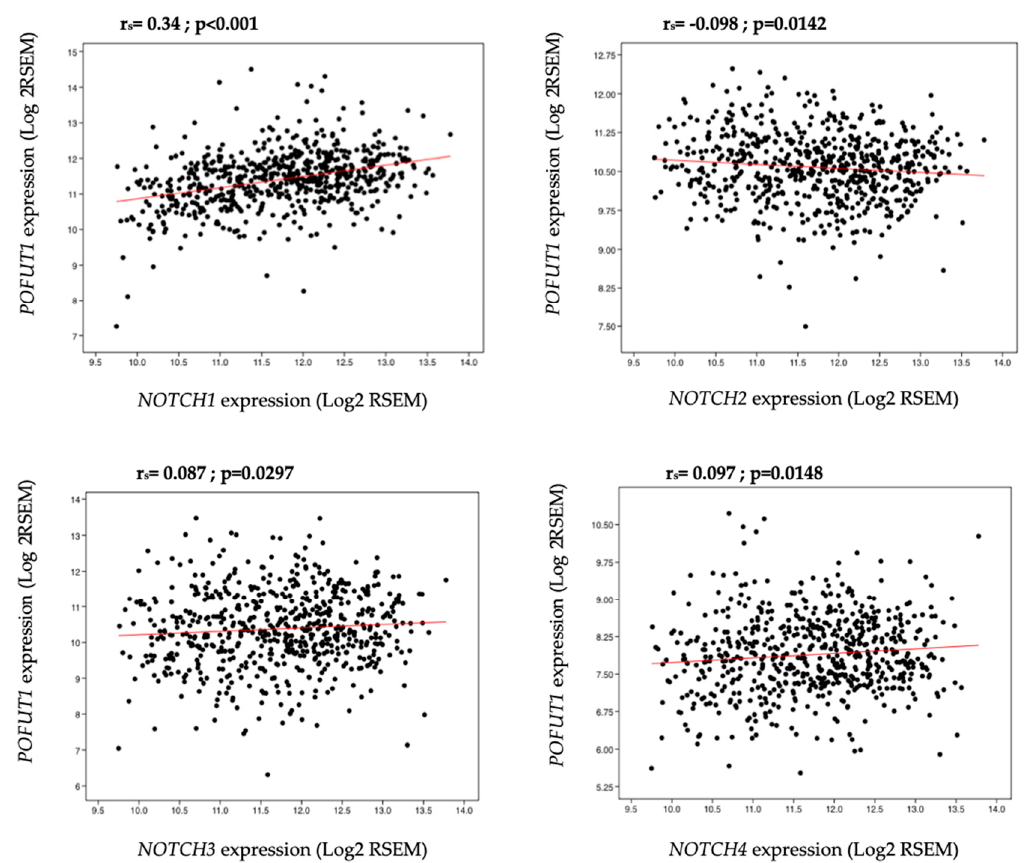
Figure 4. Correlation analysis between POFUT1 and all NOTCH receptor expressions. A total of 626 CRC data for each gene is used for a Spearman Rho correlation. In all of cases, POFUT1 expression is significantly correlated with NOTCH receptor expressions.